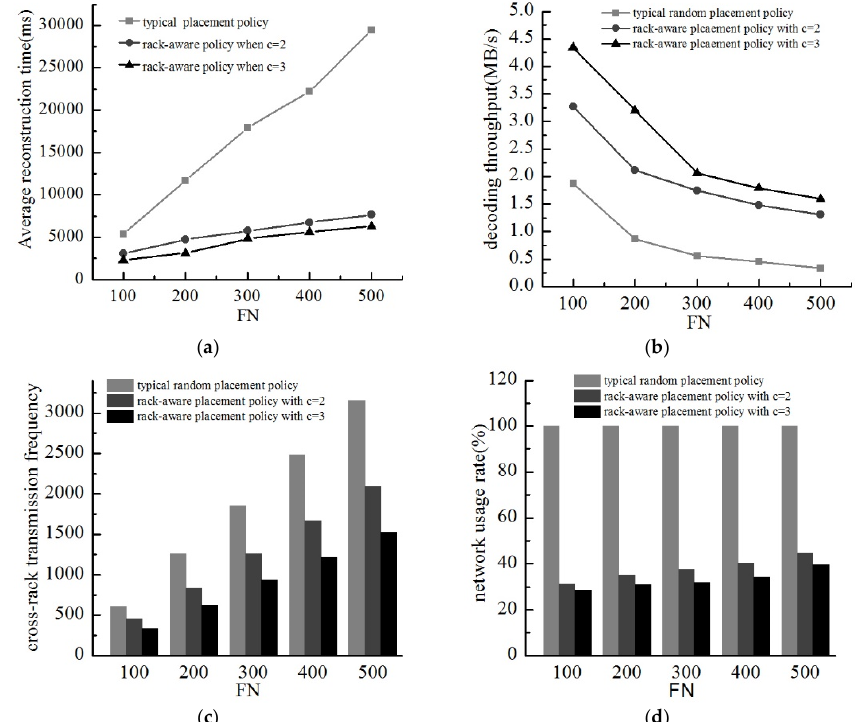
Figure 6. Data reconstruction performance of three different placement methods. ( a ) Average reconstruction time; ( b ) Decoding throughput; ( c ) Cross ‐ rack transmission frequency; ( d ) Network usage.